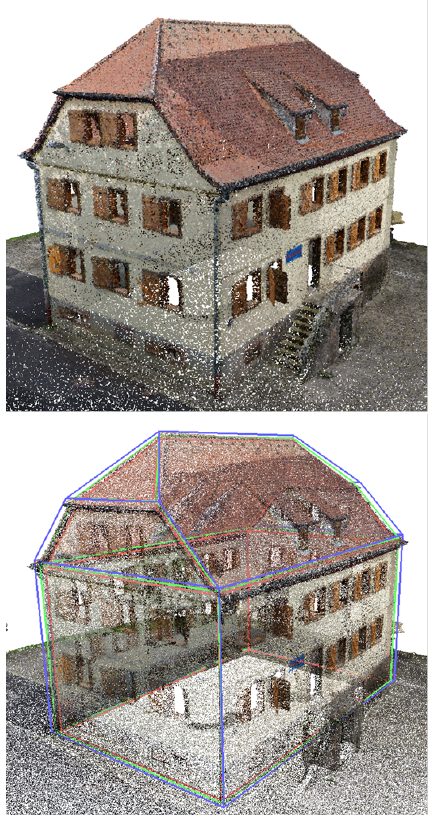
Figure 7. Building detection from point cloud (top) with shell model (bottom). Figure 8. Detection of windows and doors with a ConvNet on a planar facade. Image parts of the facade are projected onto the facade plane using corresponding 3D coordinates. The final results are projected back into the 3D model.